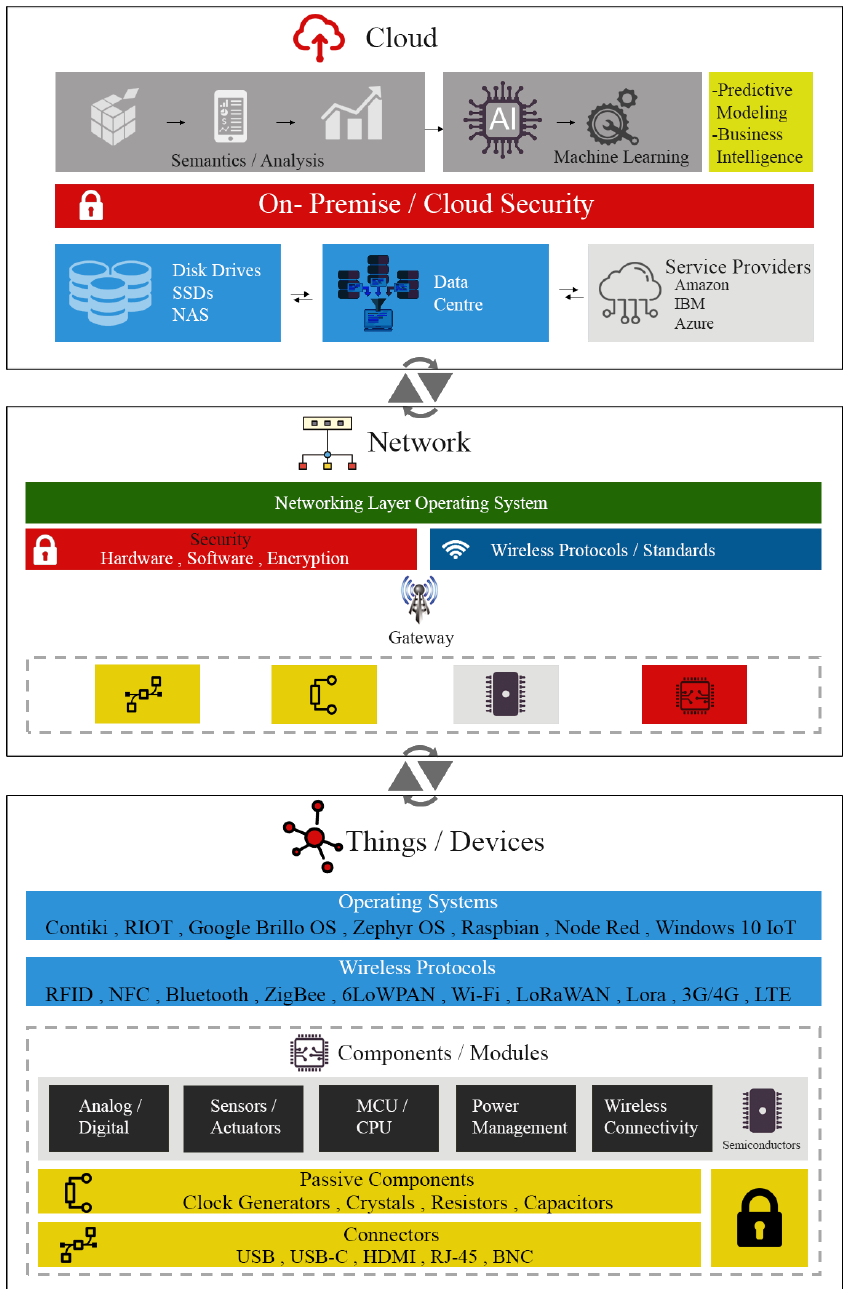
Figure 4. IoT architecture model: technology fabric from physical (PHY) to application (APP)